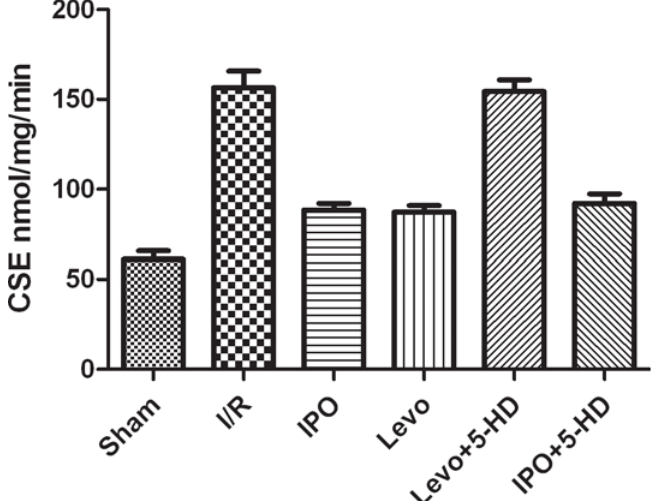
Figure 5. Results of CSE